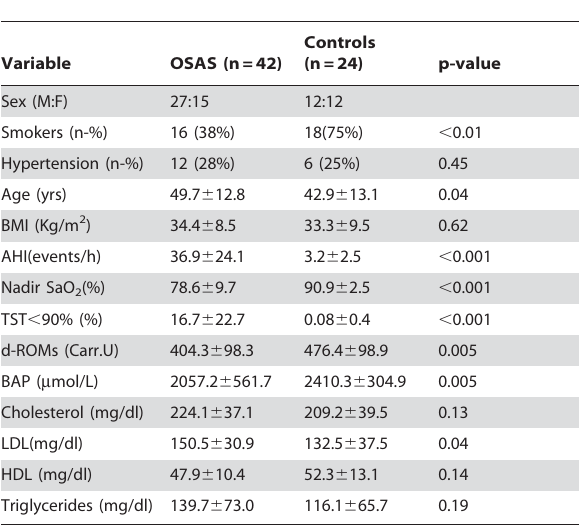
Table 1. Comparison between OSAS patients and control subjects.